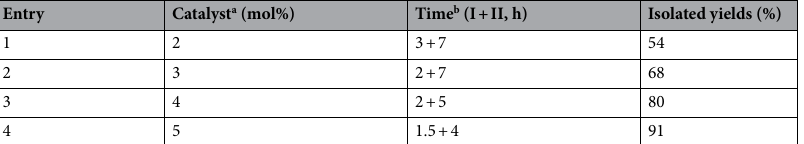
Table 3. Synthesis of 2-amino-3-cyano-4 H -chromenes via multicomponent TOP using different amounts of the catalyst. a Amount of the catalyst is based on W content and relative to alcohol. b Reaction conditions: